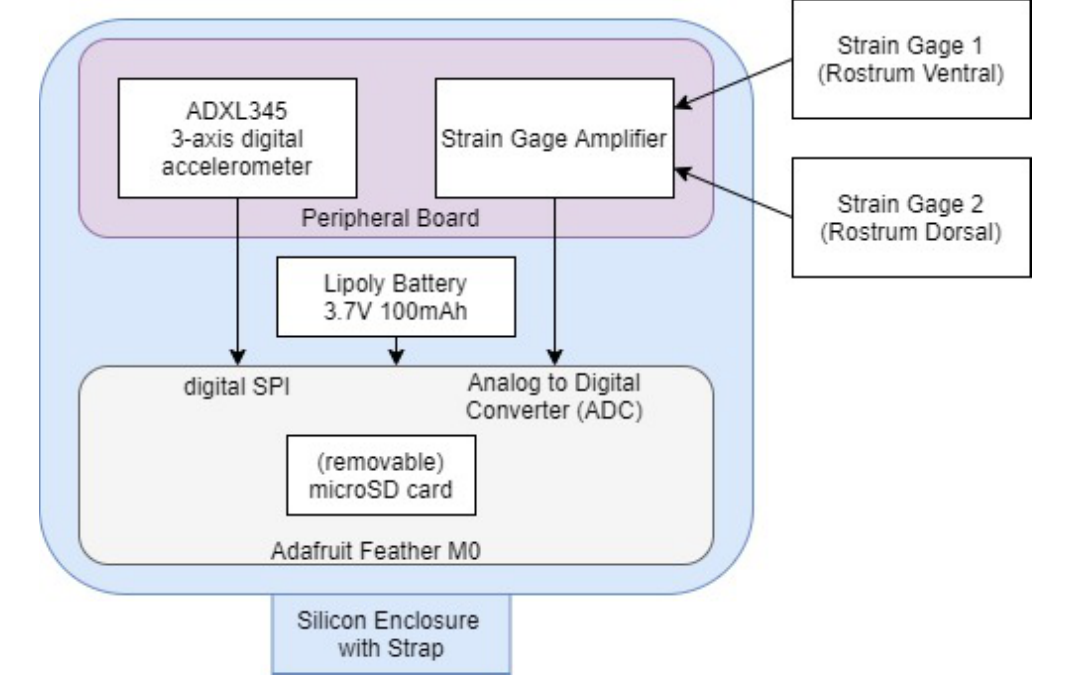
Figure 2. Instrumentation design concept.